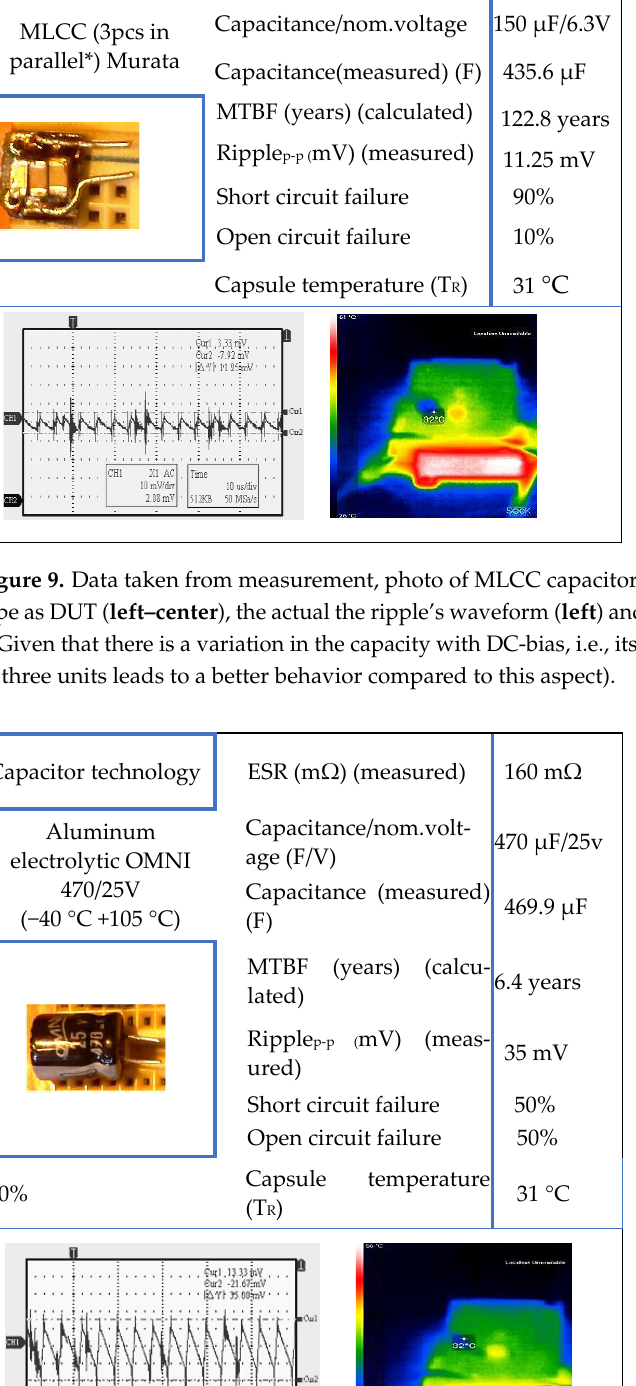
Figure 10. Data taken from measurement, photo of aluminum electrolytic capacitor type OMNI 470/25V (−40 °C +105 °C) as DUT (left– center), the actual the ripple’s waveform (left) and surface capacitor’s temperature which is required in reliability calculation (right).